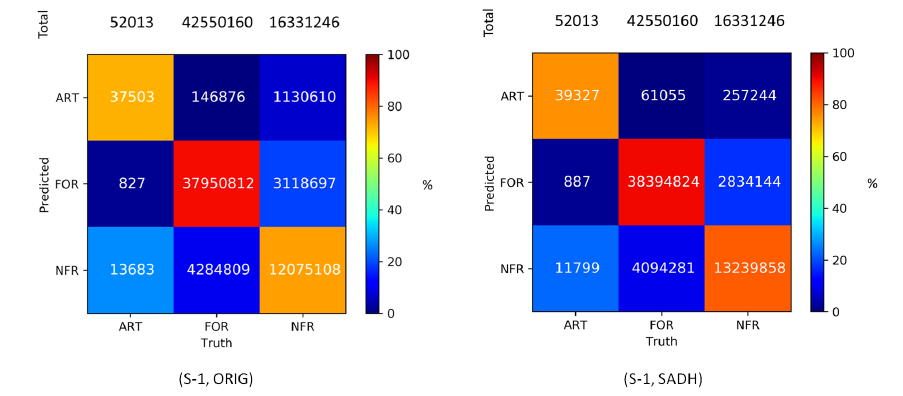
Figure 7. Confusion matrices for the whole test dataset, considering the two analyzed cases, (ORIG) and (SADH). The sum of all the elements along each column correspond to the total number of pixels associated to each class. The elements along the diagonal of the confusion matrix correspond to the correctly predicted pixels, class-by-class. The color associated to each element corresponds to the percentage obtained by normalizing the current element for the total number of samples for each specific class.